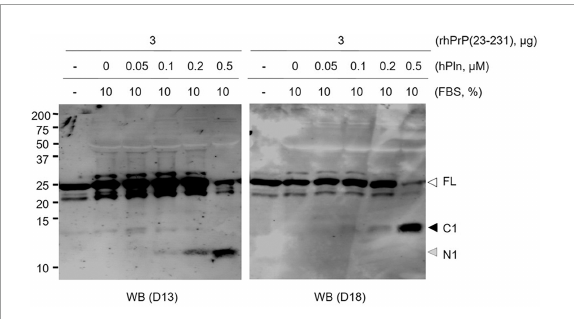
FIGURE1 Plasmin cleaves rPrP in vitro . rhPrP(23-231) was treated with increasing concentrations of hPln in DMEM with 10% FBS. Western blot analysis was utilized to visualize plasmin-generated C-terminal (D18) and N-terminal (D13) fragments for rPrP. white arrow; full-length (FL) rPrP; black arrow, C1 fragment; gray arrow, N1